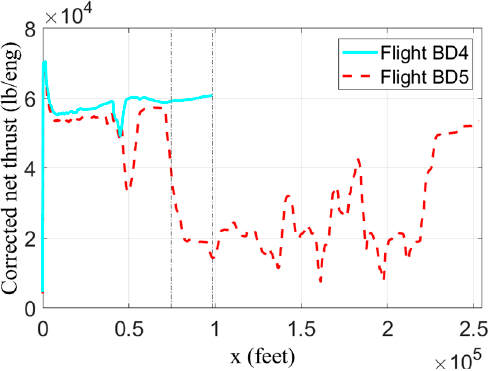
Figure A7. Power settings (engine thrust) evolution of flights BD4 and BD5.